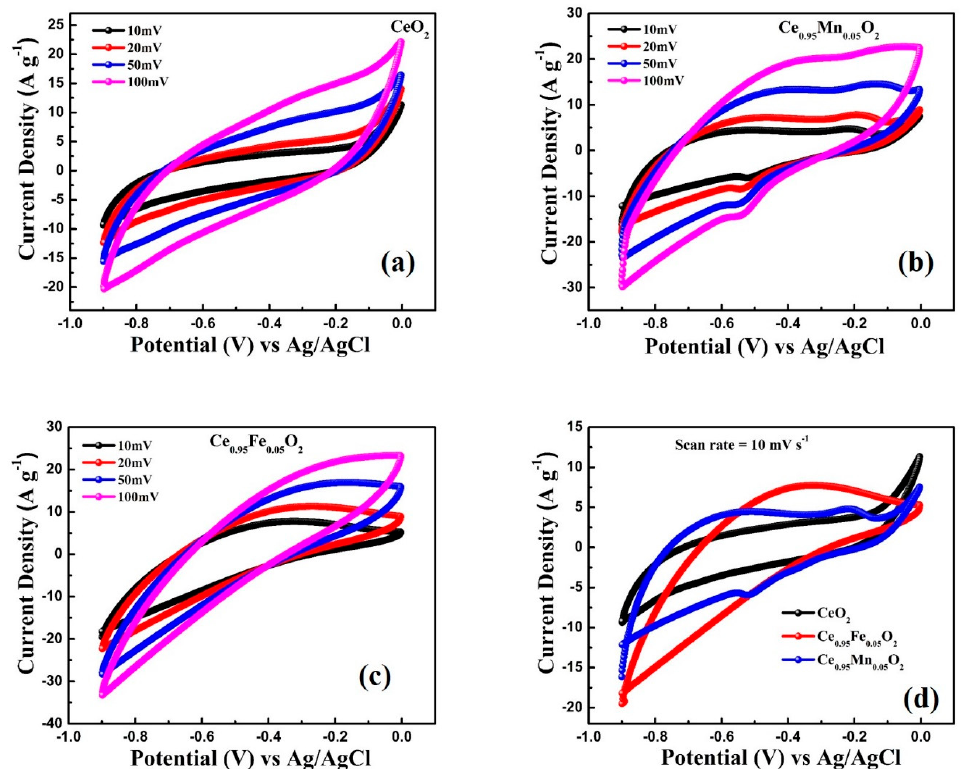
Figure 8. CV plots of ( a ) CeO 2 nanoparticles, ( b ) Ce 0.95 Mn 0.05 O 2 nanoparticles, ( c ) Ce 0.95 Fe 0.05 O 2 nanoparticles with different scan rates ( d ) CV plots CeO 2 , Ce 0.95 Mn 0.05 O 2 , Ce 0.95 Fe 0.05 O 2 nanoparticles at a scan rate of 10 mV S − 1 .